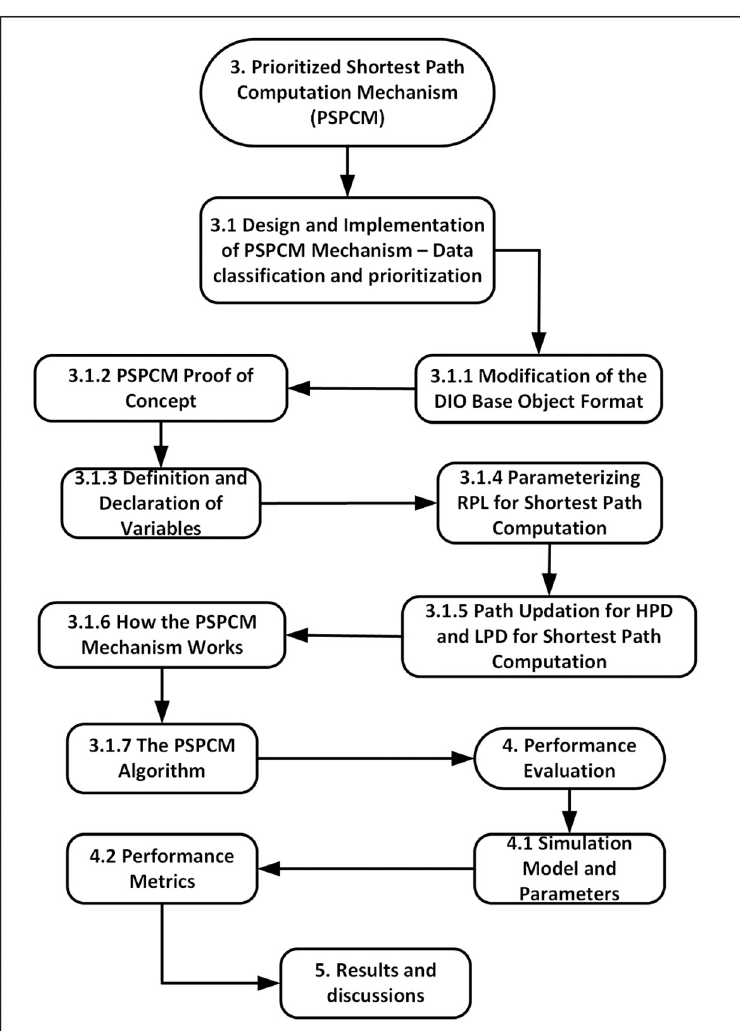
Fig 2. PSPCM methodological